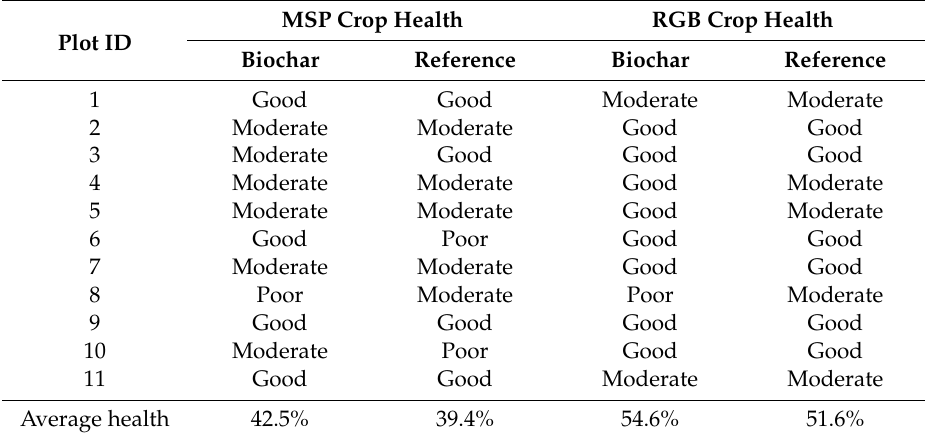
Table 4. Categorical classification of the crop health into good, moderate, and poor classes comparing the century-old biochar versus reference plots. The classification is based on the multispectral (MSP) crop health (left) and the first component (PC1) of the principal component analysis (PCA) of the green and red spectral channels of the RGB orthomosaic image (right).